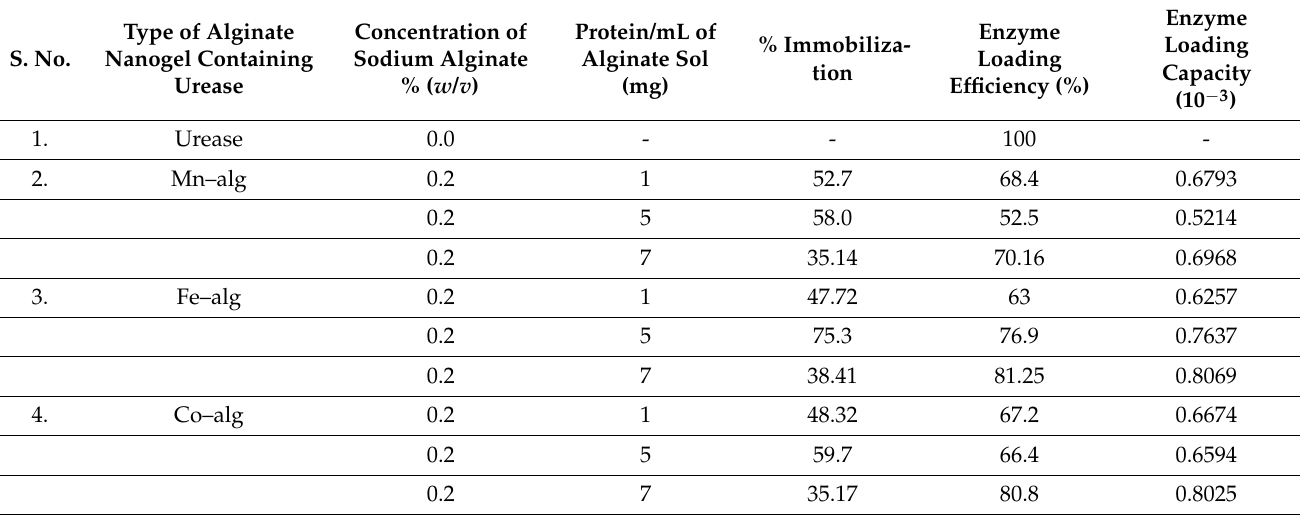
Table 4. Parameters of enzyme immobilization measured in alginate nanogels cross-linked with polyvalent cations (Mn 2+ , Fe 3+ , or Co 2+